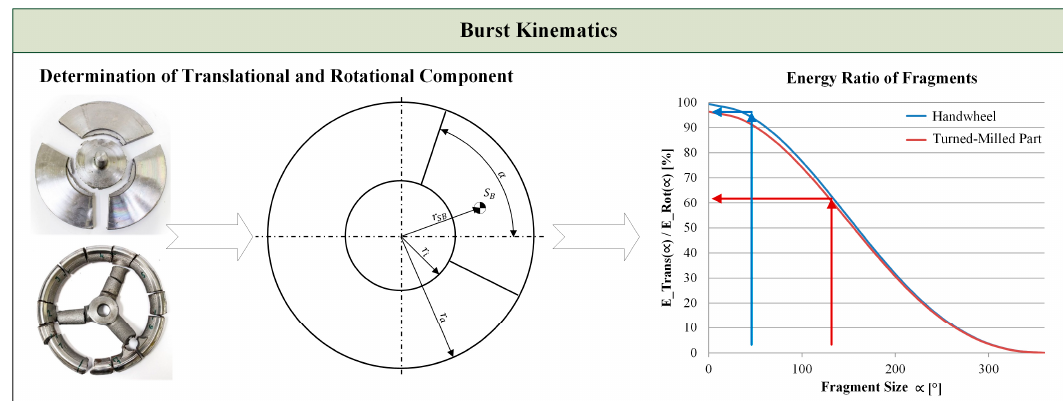
Figure 15. Step 3a—Determination of rotor fragment geometry and shares of energy.